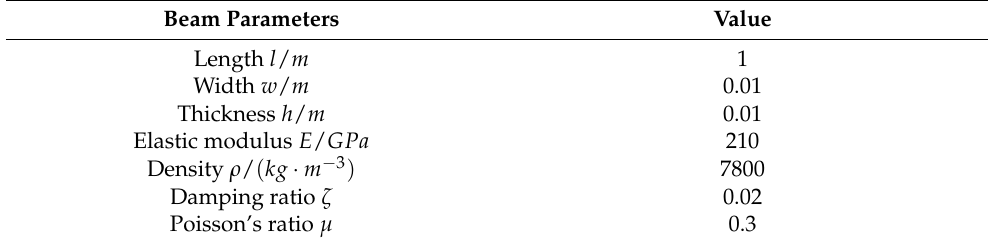
Table 1. The beam parameters.